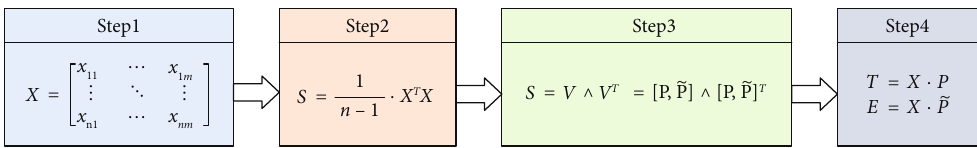
Figure 4: General process of PCA.